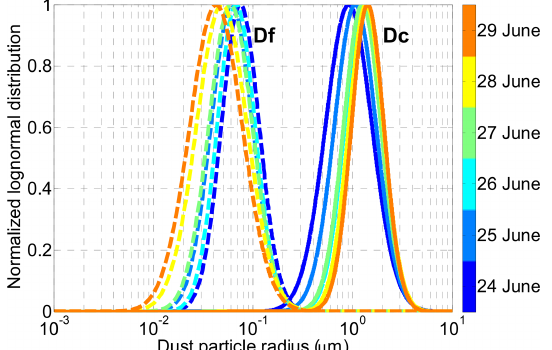
NCEP (National Centers for Environmental Prediction) re-